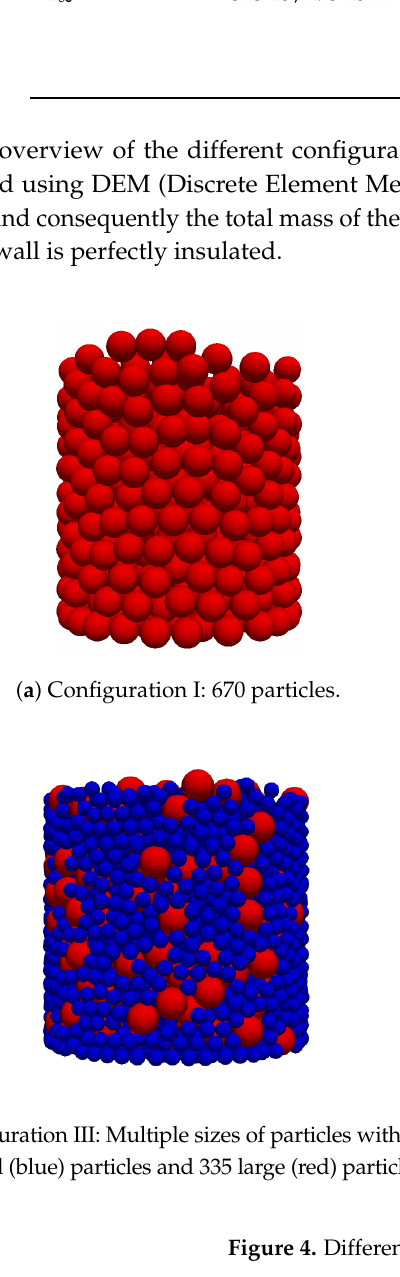
Figure 4. Different configurations of